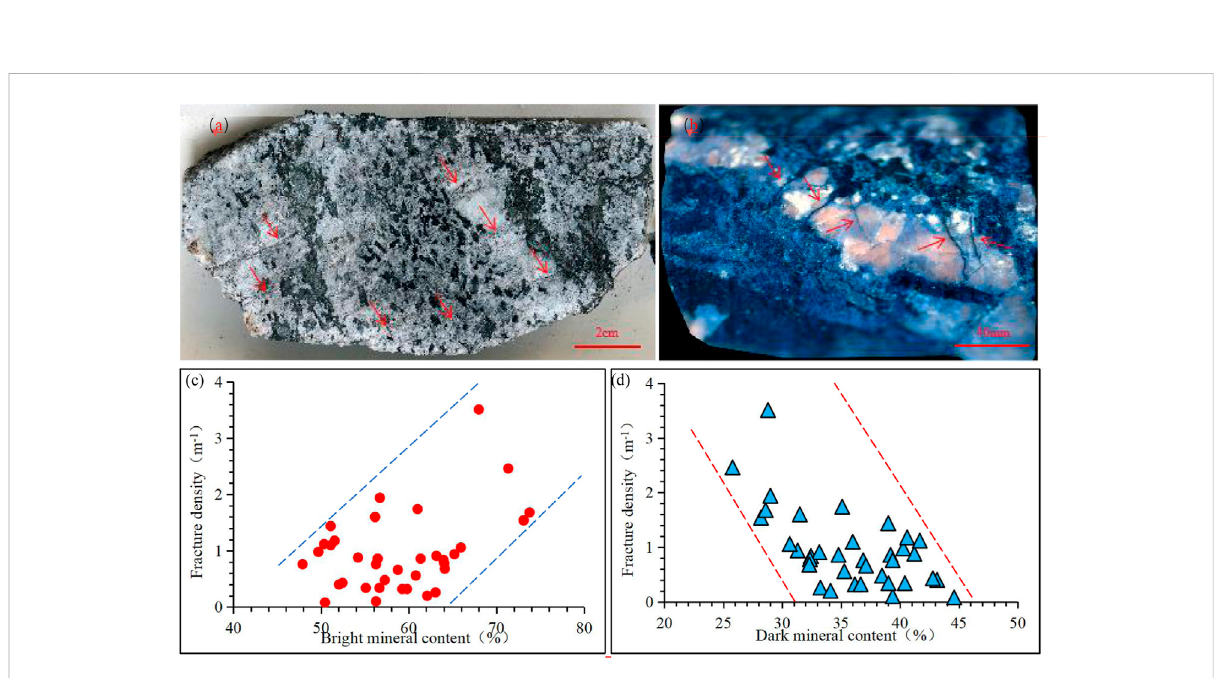
FIGURE 6 Controlling of lithology on fracture distributions. (A,B) Variation in fracture development with mineral types. (C) Relationship between bright mineral contents and fracture development. (D) Relationship between dark mineral contents and fracture development.